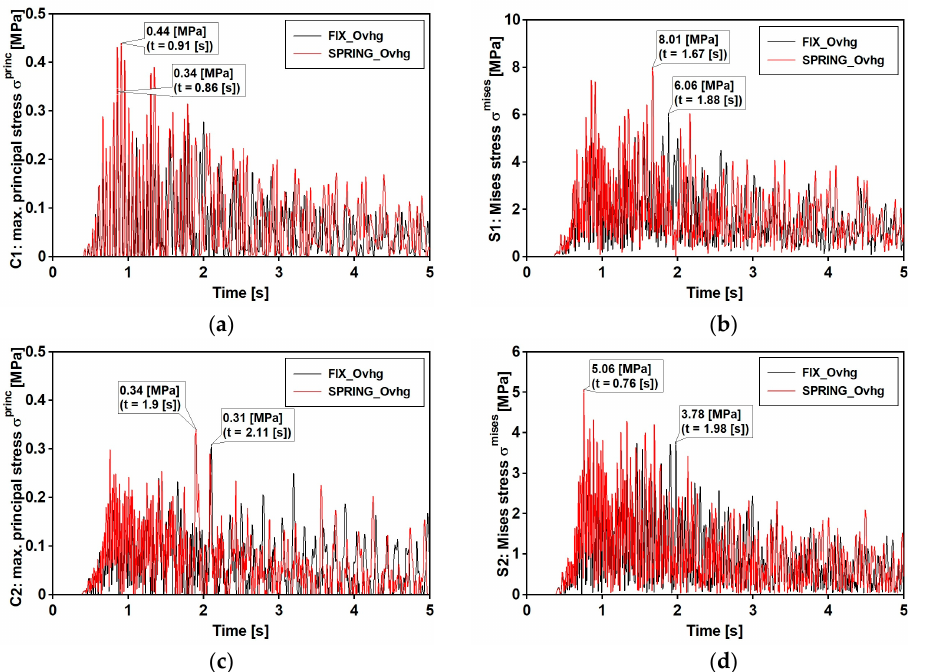
Figure 22. Mining-induced stress [kPa] time histories: event with wide band spectrum. FIX_Ovhg model (black line) and SPRING_Ovhg model (red line): ( a ) positive value of principal stresses σ princ at points C1 ( b ) positive value of principal stresses σ princ at points C2; ( c ) the von Mises stresses σ mises for points S1; ( d ) the von Mises stresses σ mises for points